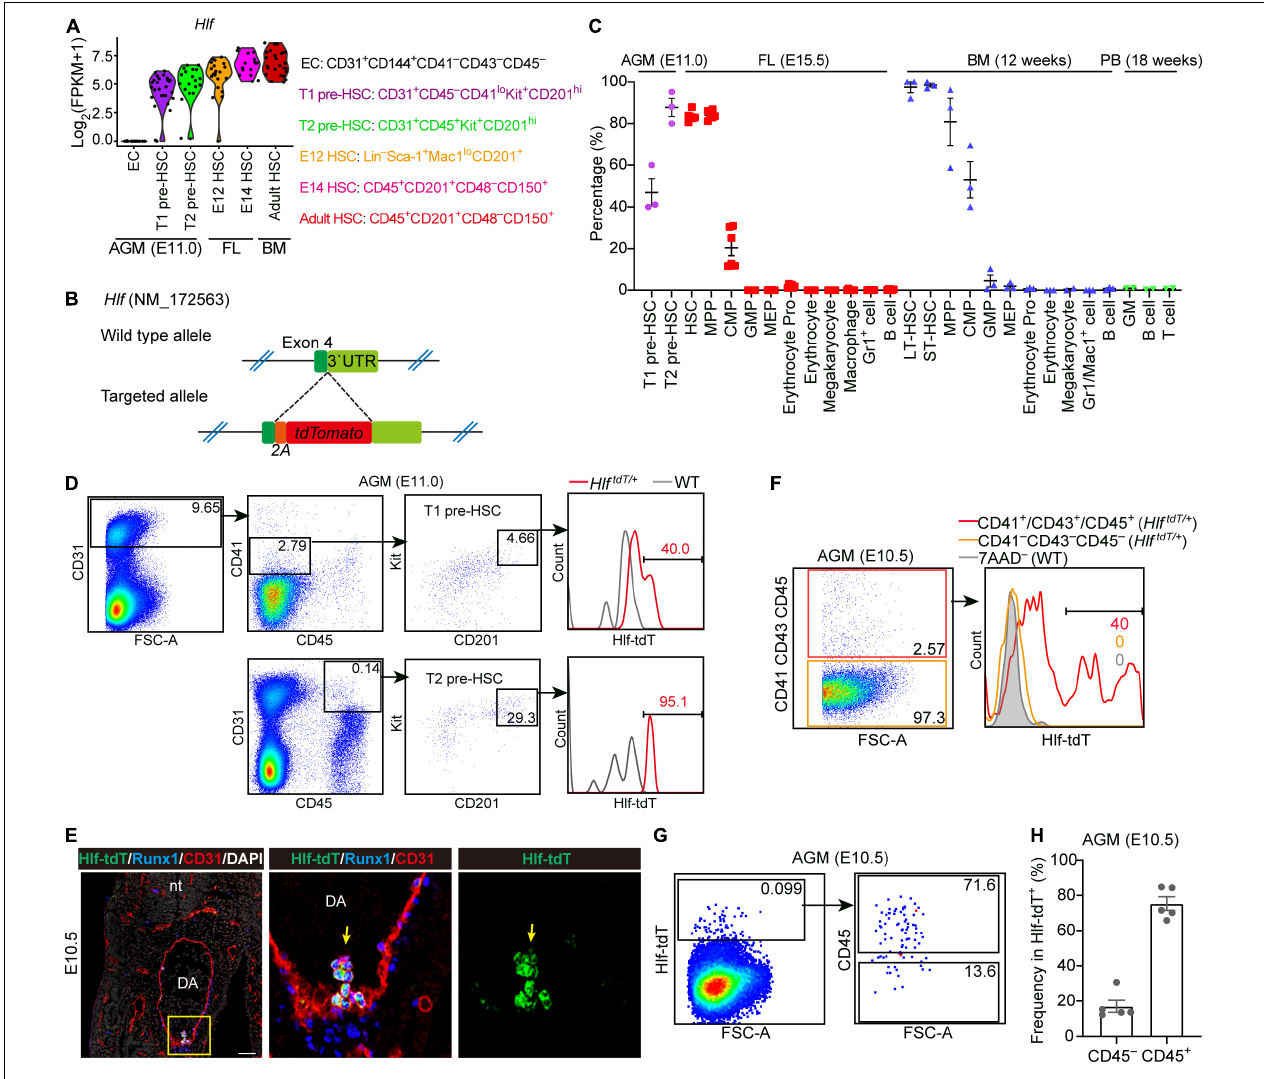
FIGURE 1 | Establishment of an Hlf-tdTomato reporter mouse model. (A) Violin plots showing the transcription level of Hlf in six populations as indicated. Data are from GSE67120. (B) Schematic model of the gene-targeting strategy for constructing Hlf-tdTomato reporter mouse line via CRISPR/Cas9 system. (C) Graph showing the percentage of Hlf-tdTomato expression in each hematopoietic population of the E11.0 AGM region, E15.5 fetal liver (FL), adult bone marrow (BM), and peripheral blood (PB). Data are shown as means ± SEM from at least two independent experiments. MPP, multipotent progenitor; CMP, common myeloid progenitor; GMP, granulocyte-monocyte progenitor; MEP, megakaryocyte-erythroid progenitor; erythrocyte pro, erythrocyte progenitor; LT-HSC, long-term hematopoietic stem cell; ST-HSC, short-term hematopoietic stem cell. (D) Representative FACS plots showing the Hlf-tdTomato expression in T1 and T2 pre-HSCs in the AGM region of E11.0 Hlf-tdTomato embryos. Data are representative of three independent experiments. Hlf tdT / + , Hlf tdTomato / + ; WT, wild type. (E) Representative immunostaining on sections from the AGM region of E10.5 Hlf-tdTomato embryos. Arrows indicate Hlf-tdTomato + IAHCs. The two images to the right present the high magnification view of yellow box. nt, neural tube; DA, dorsal aorta. Scale bar, 50 µ m. (F) Representative FACS plots showing the proportion of Hlf-tdTomato positive cells in CD41 − CD43 − CD45 − and CD41 + /CD43 + /CD45 + populations in the AGM region of E10.5 Hlf-tdTomato embryos. Data are representative of two independent experiments. Genotypes are indicated in the brackets. Hlf tdT / + , Hlf tdTomato / + ; WT, wild type. (G) Representative FACS plots showing the CD45 expression in Hlf-tdTomato + cells in the AGM region of E10.5 Hlf-tdTomato embryos. (H) Graph showing the frequencies of CD45 − or CD45 + cells in Hlf-tdTomato + cells of the E10.5 AGM region. Data are shown as means ± SEM from five independent